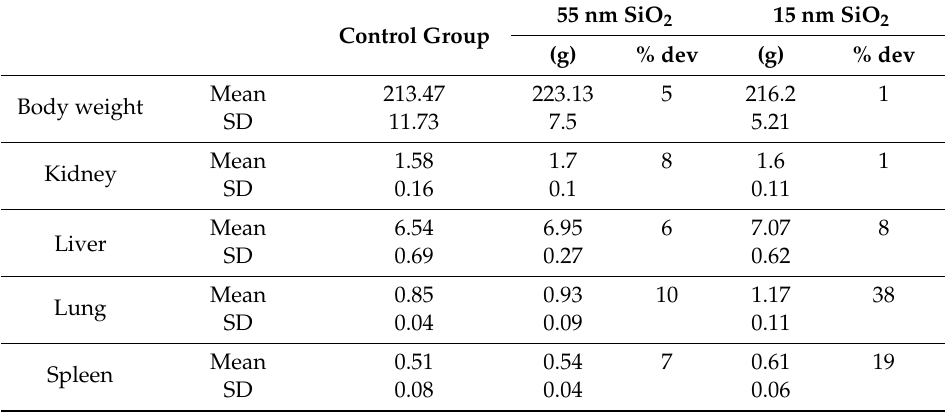
Table 4. Effects of 55 nm and 15 nm SiO 2 in a rat intratracheal instillation study: terminal body weight and organ weight (three animals per group).